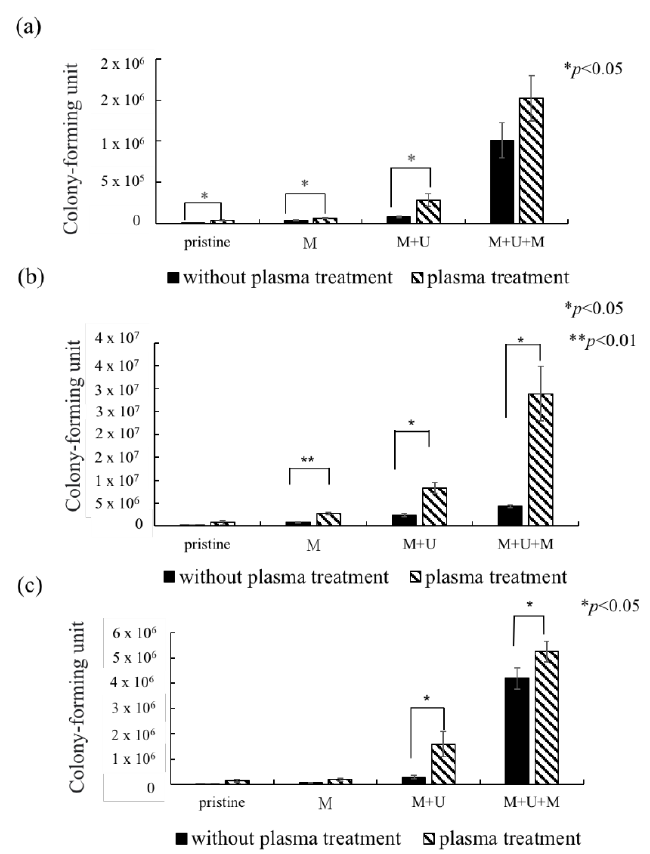
Figure 5. The growth of H. pylori on photo-cured resin and ABS after culture for 24 h. ( a ) IR:IBOA = 6:1, ( b ) IR:EOEOEA = 6:1, ( c ) ABS. M means mucin coating, M + U means mucin/urea coating, and M + U + M means mucin/urea/mucin coating. (*) indicates a significant difference from each group.